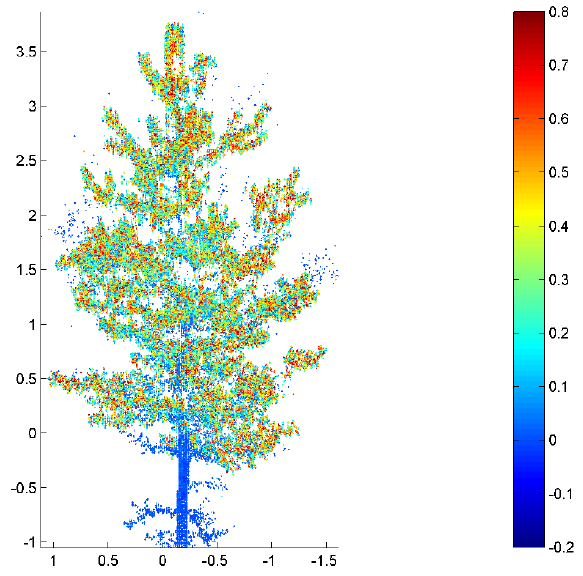
Figure 3. A 3D distribution of Modified Chlorophyll Absorption Ratio Index (MCARI) over the pine